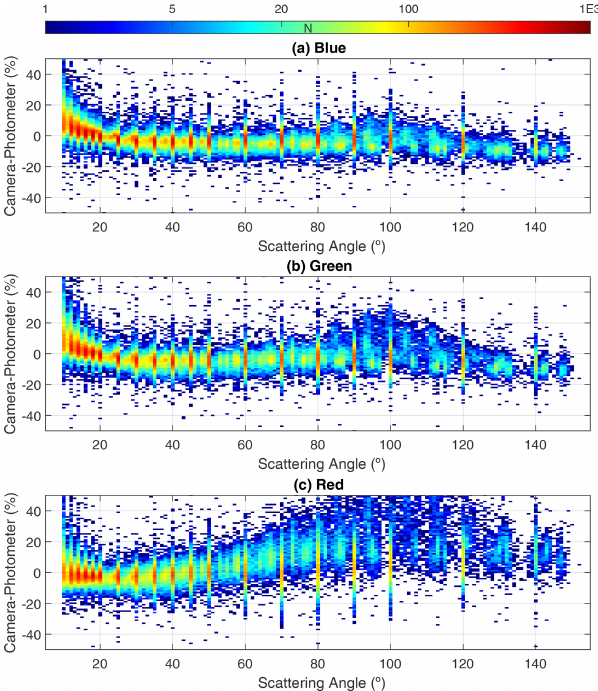
Figure 12. Relative differences between the camera and photome- ter normalized radiances as a function of the scattering angle for blue (a) , green (b) and red (c) channels. Radiances with scattering angles below 10 ◦ are not